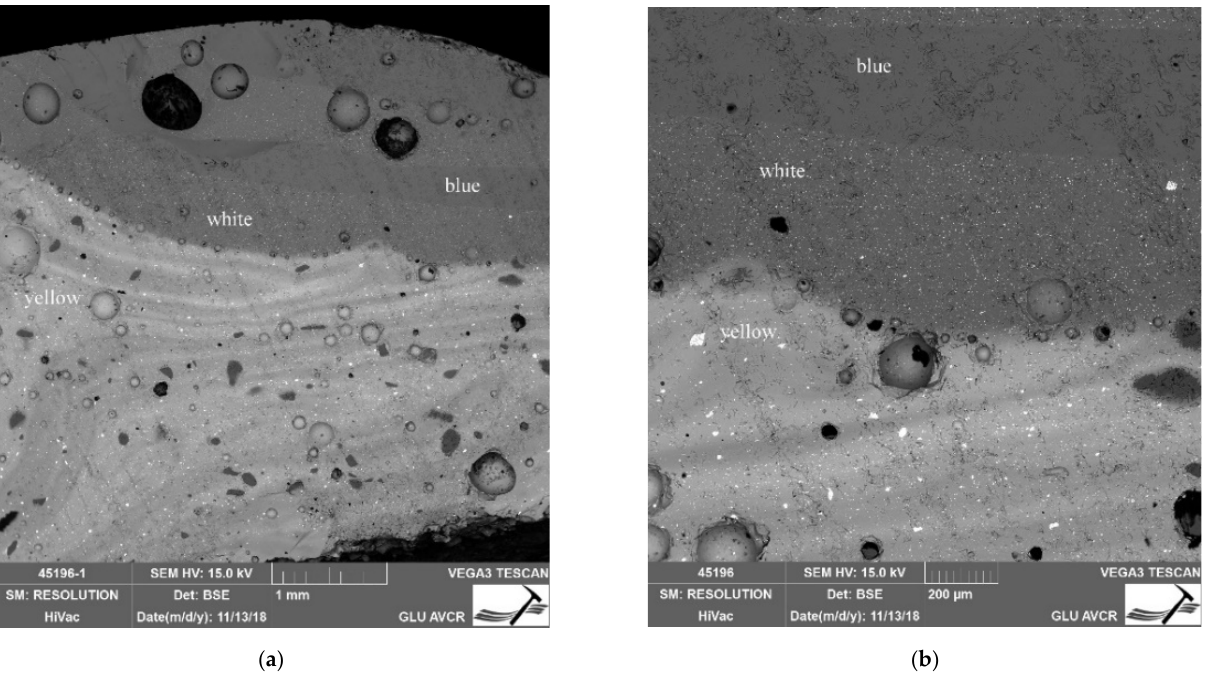
Figure 9. Glass Layer Stratigraphy of Bead No. 20. ( a ) Yellow glass bead decorated with white and blue eyes. The structure of yellow glass (bottom) is clearly visible, with distinct grains of SiO 2 ; ( b ) detail of the previous image ( a ). The distribution of opacifiers is more uniform in the white glass and their particles are smaller than those found in yellow glass. At the color interface, a band of bubbles is clearly visible-created when the decoration was applied on the already cooled surface of the base bead.